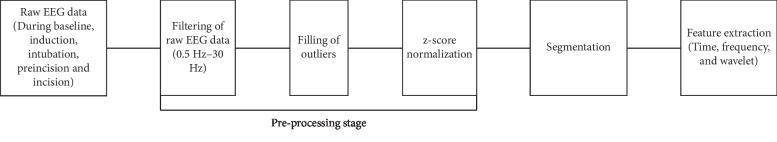
Block diagram of the proposed model.